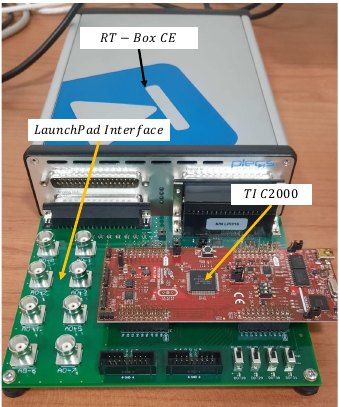
Figure 11. RT-Box CE with the Launchpad Interface.